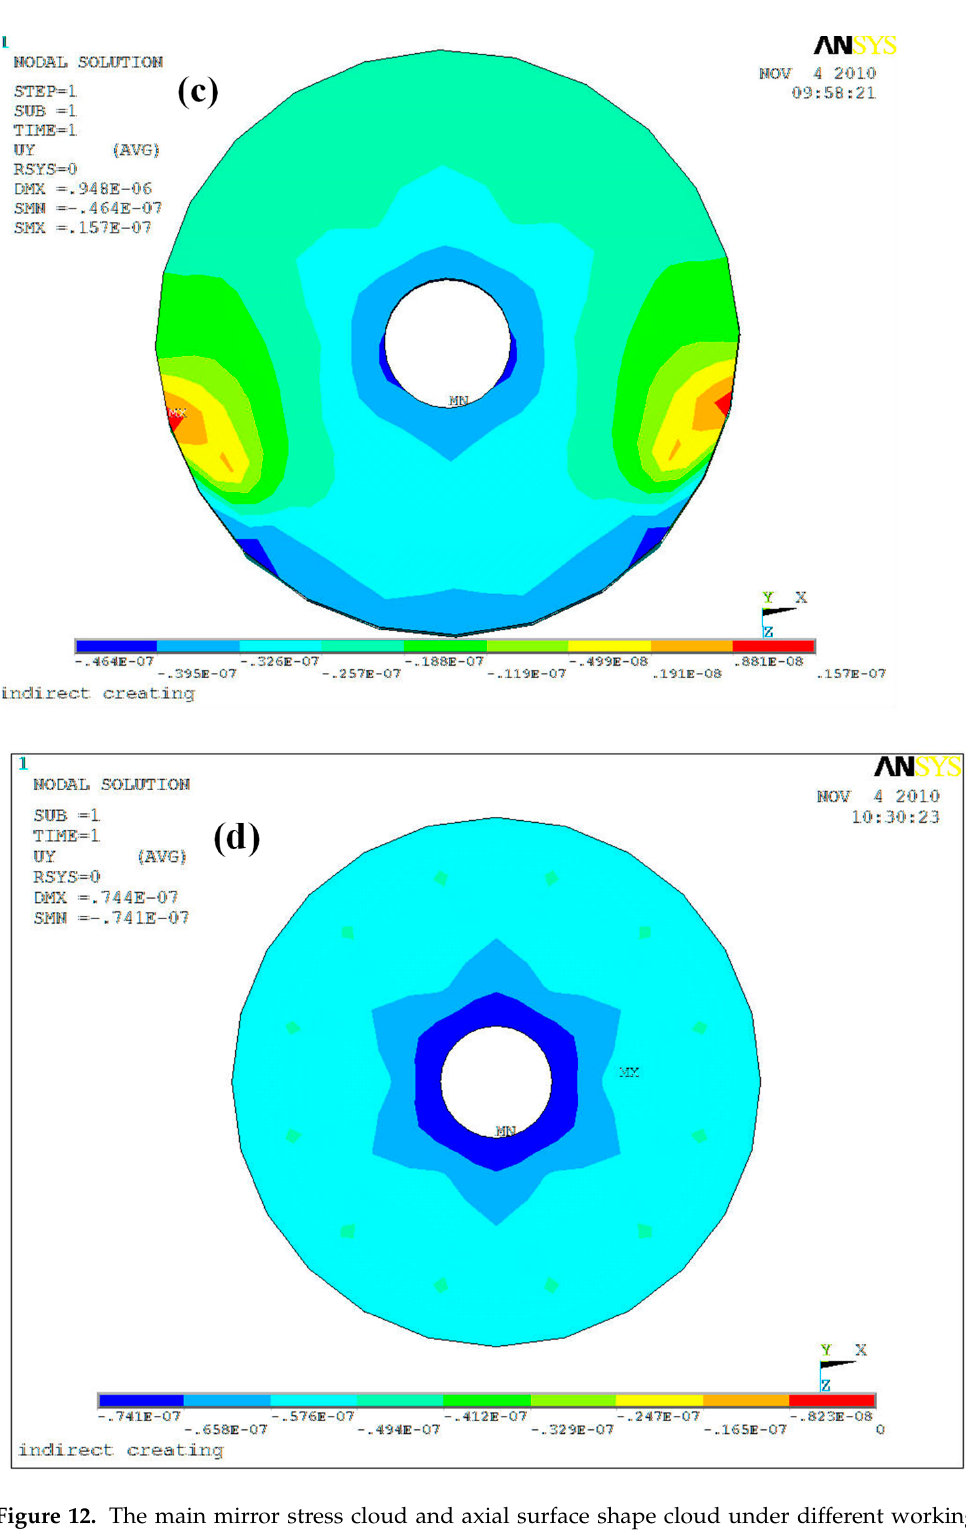
Figure 12. The main mirror stress cloud and axial surface shape cloud under different working conditions. ( a , c ) 30° ( b , d ) 90°.